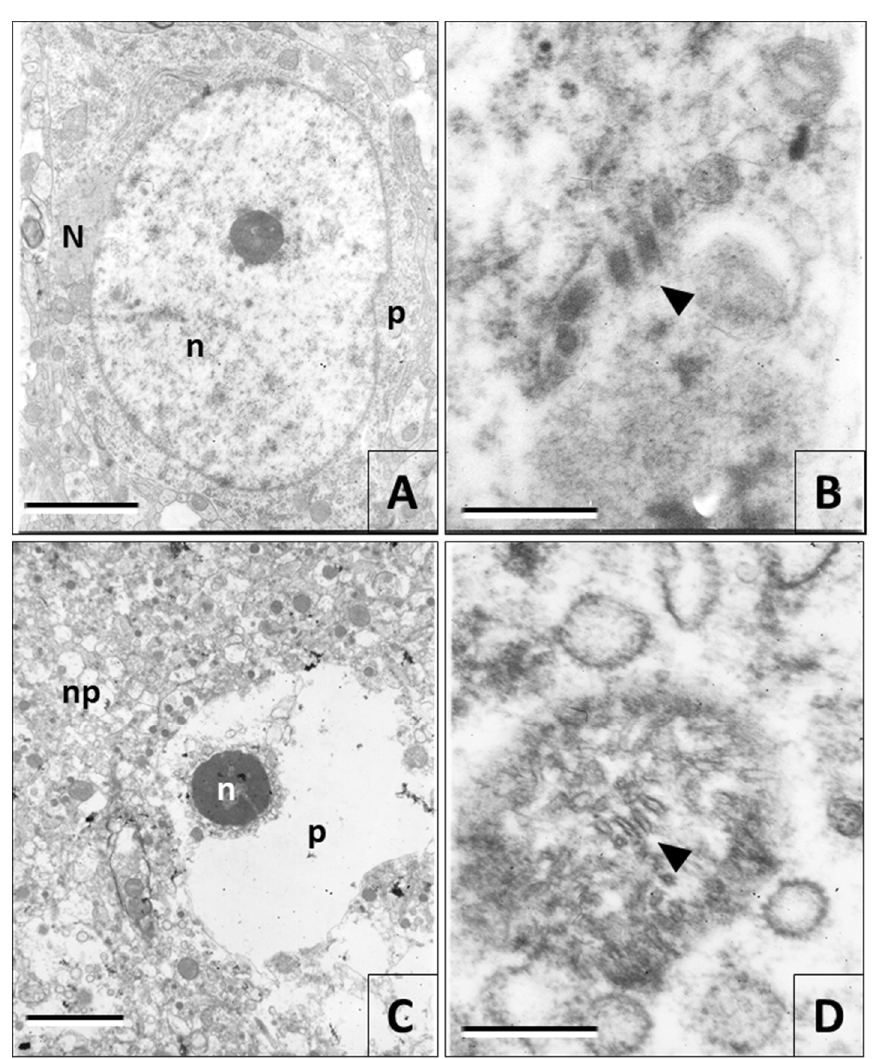
Figure 5. Electron microscopy images. ( A ) Picture of a neuron of a mouse cerebral cortex infected with rabies and fixed by perfusion (0 h postmortem). Alterations in the nucleus ultrastructure ( n ) or the perikaryon ( p ) were not observed, but the presence of a viral ribonucleoprotein inclusion (N) in the cytoplasm is noted. ( B ) Rabies virus particles (arrowheads) in brain tissue at 0 h postmortem. (C and D) Ultrastructural images of nervous tissue processed at 30 h postmortem. ( C ) Neuropile (np) degradation is noteworthy, as well as that of a neuron presenting nucleus retraction (n) and autolysis. ( D ) Structure that probably corresponds to a mitochondrion in a degradation process with fragments of membranes that can be confused with viral particles (arrowhead). (Magnifications. A = 7000 × ; B = 50,000 × ; C = 3000 × ; D = 50,000 × ) (Bars. A = 2400 nm, B = 200 nm, C = 4800 nm, D = 200 nm).